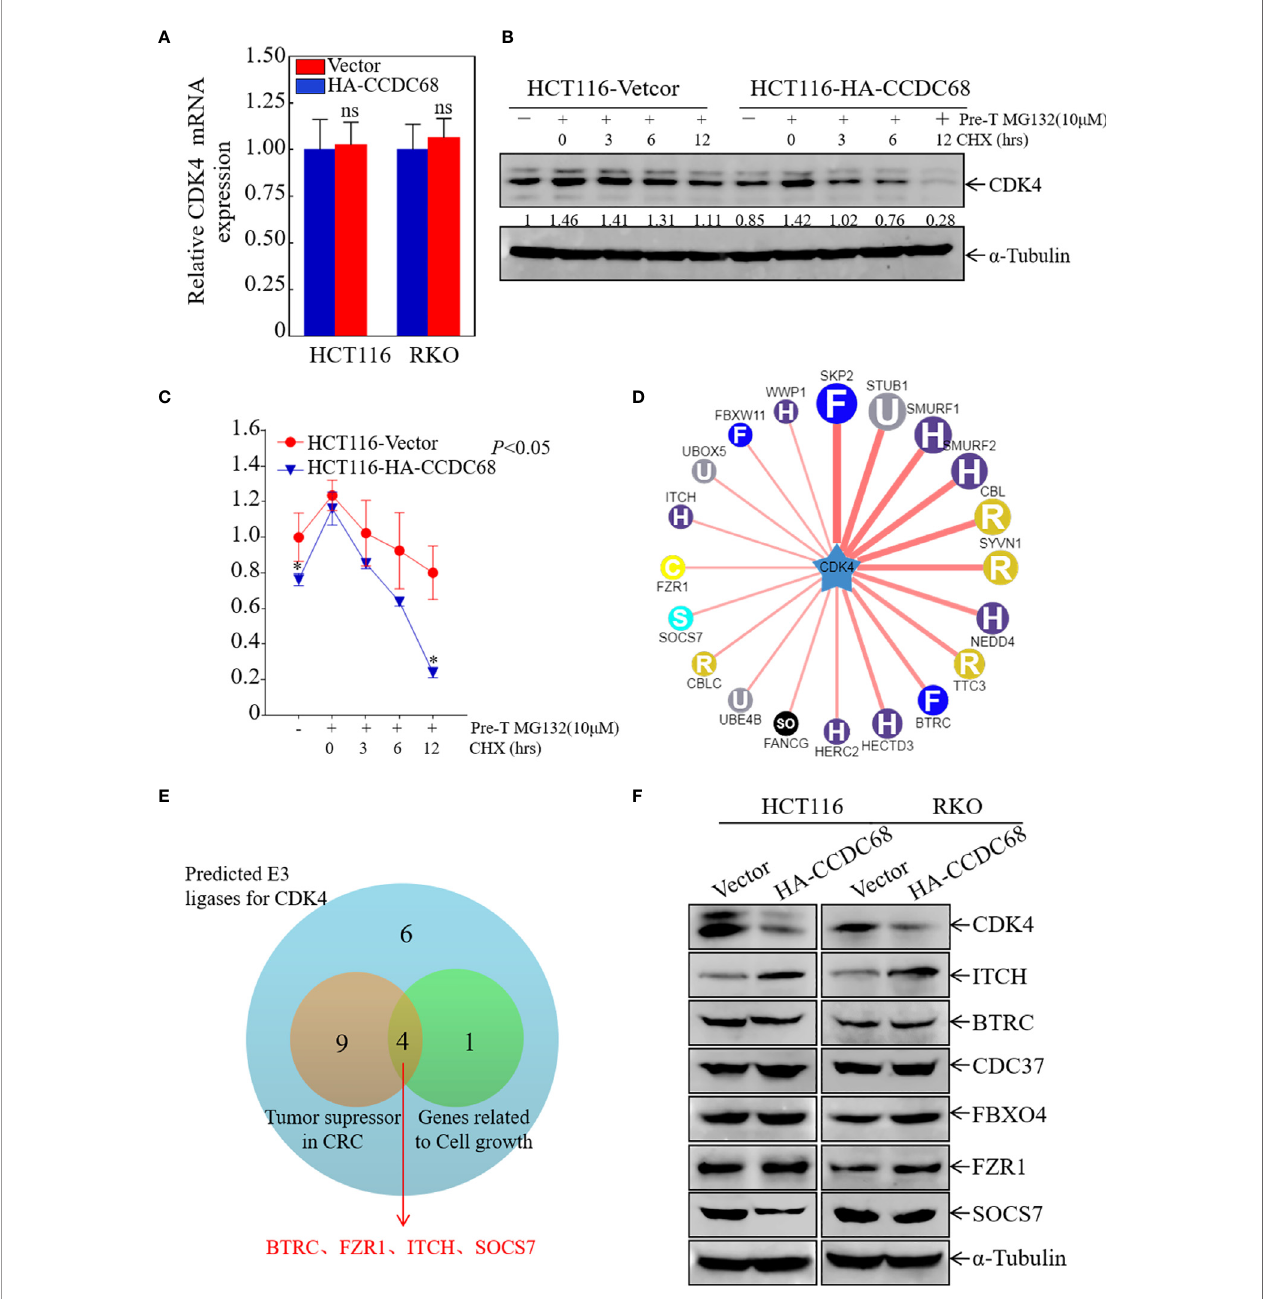
FIGURE 5 | ITCH may function as an E3 ubiquitin ligase targeting CDK4for degradation. (A) Relative CDK4mRNA expression inHCT116 (Vector/HA-CCDC68)and RKO (Vector/HA-CCDC68)cells. Student ′ s t -test, ns, not signi fi cant. (B) CDK4protein degradation was monitoredin HCT116 (CCDC68)and HCT116 (Vector)cells pretreated with MG132 for 5 h followedby CHX for varioustimes. (C) CDK4 protein degradation rates in HCT116 (CCDC68)and HCT116 (Vector)cells. Three independent degradation experiments were performed,and the results were analyzed usingImageJ software and analyzed byStudent ′ s t -test. *P < 0.05. (D) Molecules potentially involved inthe regulation of CDK4 protein degradation were predictedby the UbiBrowser database. (E) Venn diagram screeningthe E3 enzymes involved inthe regulation ofCDK4protein degradation. (F) Expression ofCDK4, ITCH, BTRC, CDC37, FBXO4, andSOCS7 in HCT116 (Vector/HA-CCDC68)and RKO